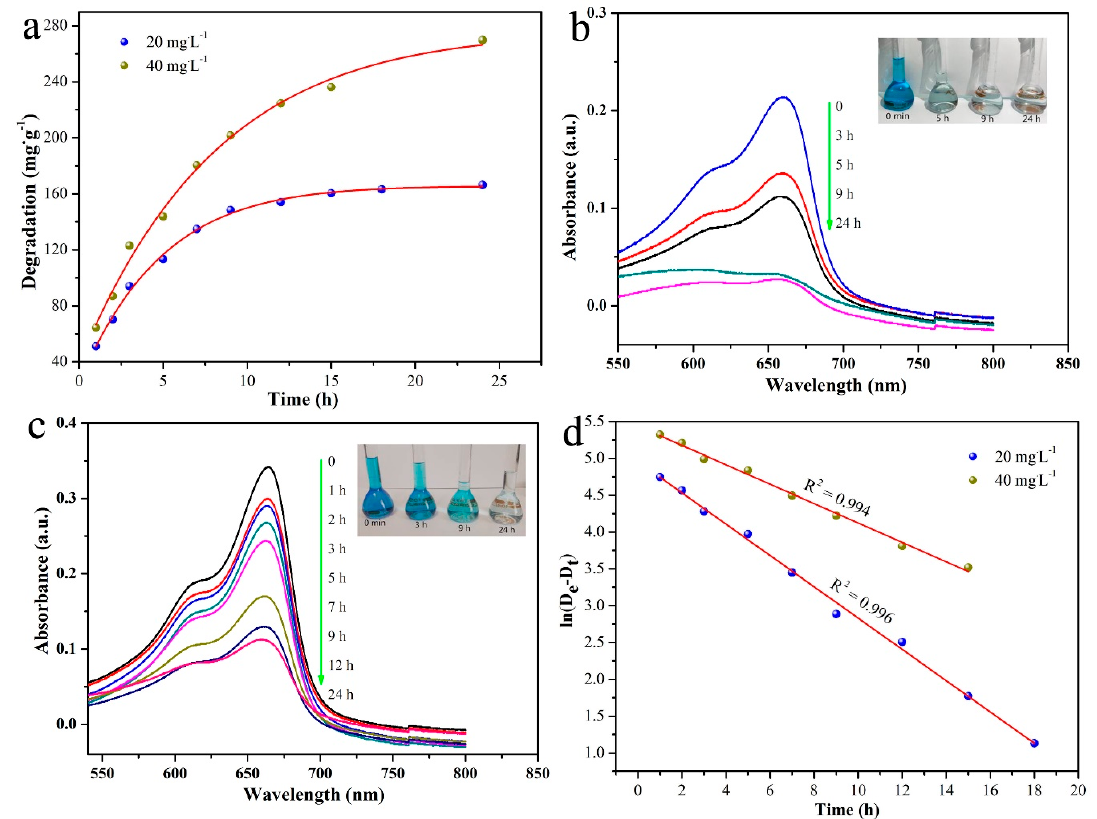
Figure 12. MB degradation curves under different MB concentrations ( a ); UV-Vis spectra of 20 mg L − 1 MB after various degradation times ( b ); UV-Vis spectra of 40 mg L − 1 MB after various degradation times ( c ); and pseudo-first-order kinetic model plot of the degradation process ( d ).